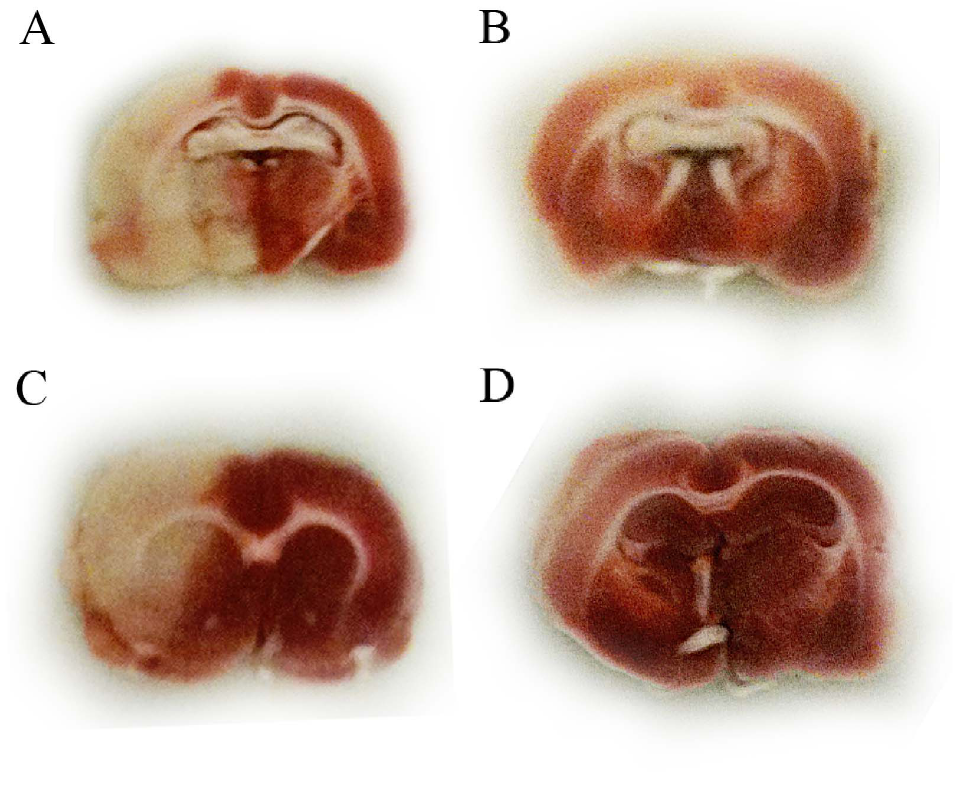
Figure 2. Representative tetrazolium chloride (TTC) stained sections of (A) transient middle cerebral artery occlusion (tMCAo) + rt- PA rats (B) sham + rt-PA rats (C) tMCAo + vehicle rats and (D) sham + vehicle rats. Dark areas reflect living viable tissue while white reflects infarcted tissue or areas of white matter. Infarcted areas occupy at least 50% of the right hemisphere in all tMCAo rats.